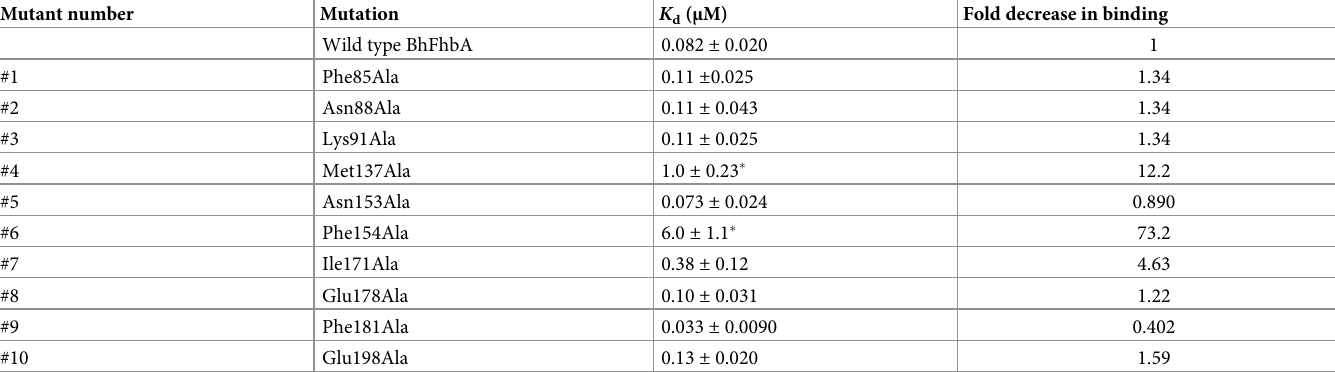
Table 2. Binding affinities of BhFhbA and mutants measured by MST. Mean binding affinities ( K d in μ M concentration ± SEM) calculated from three individual experiments (S4 Fig). Fold decrease in binding was calculated by normalizing the K d values relative to wild type BhFhbA (assigned a value of 1). � Designates p -value < 0.05 from an unpaired t -test in comparison to the wild type. n = 3 for each protein. Mutant